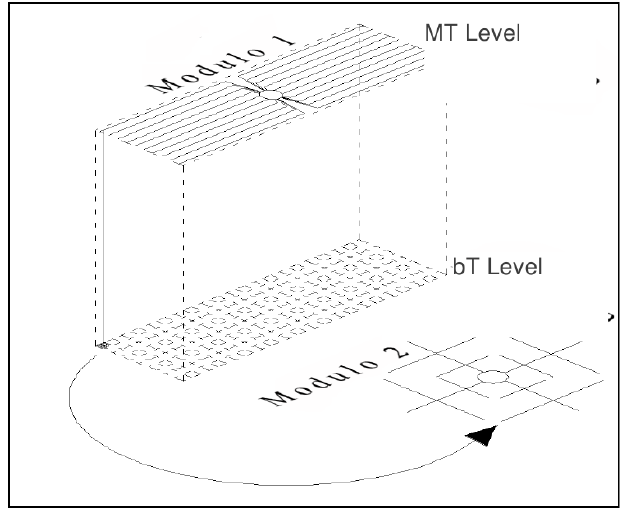
Figure 12. Modular approach to study the distribution system.